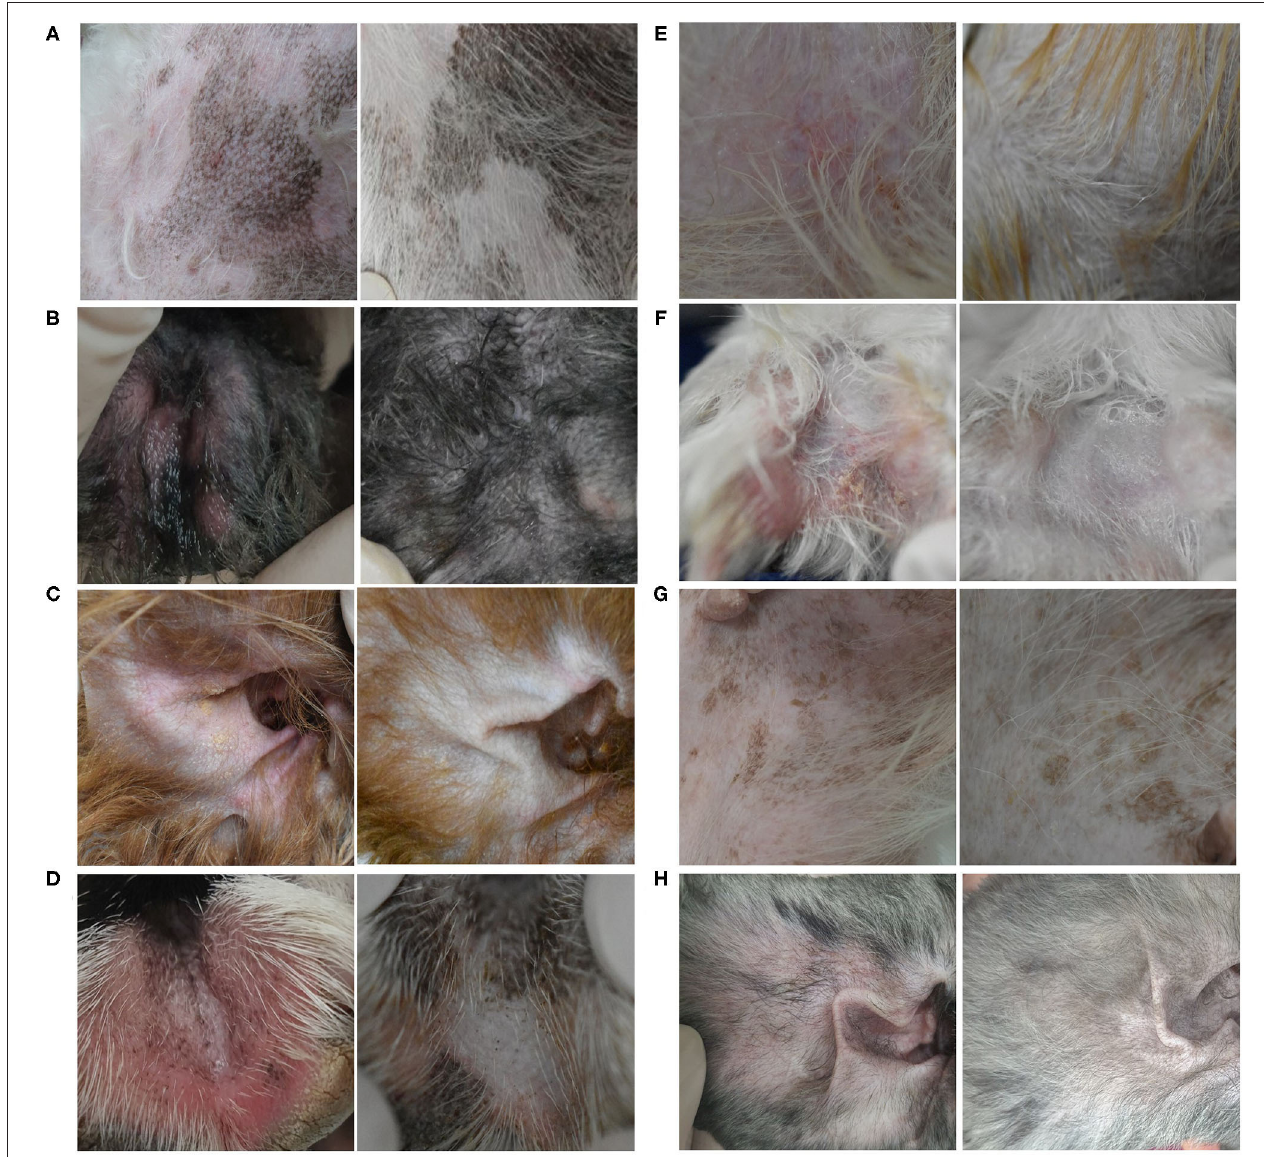
FIGURE 2 | Clinical efficacy of excimer light therapy. Clinical signs of canine atopic dermatitis were improved after 8 weeks of excimer light therapy in the allergic group. (A) Dog 11, groin. (B) Dog 13, hind paws. (C) Dog 14, ear pinnae. (D) Dog 16, front paws. (E) Dog 17, groin. (F) Dog 18, hind paws. (G) Dog 19, groin. (H) Dog 20, ear pinnae [ (Left) , before excimer light therapy; (Right) , after excimer light therapy].